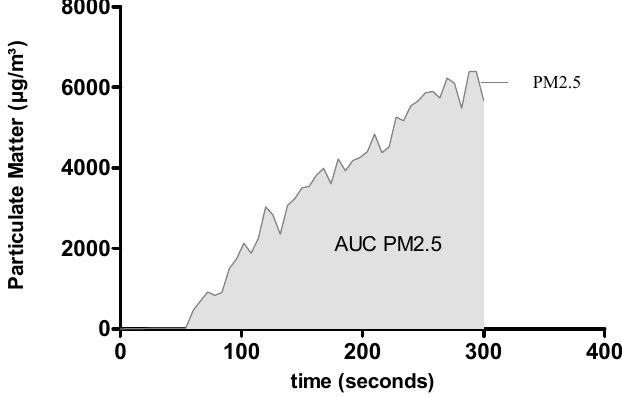
Figure 5. The interval from ignition to extinction (5 min) was evaluated by measuring the area under the curve (AUC) and particulate matter